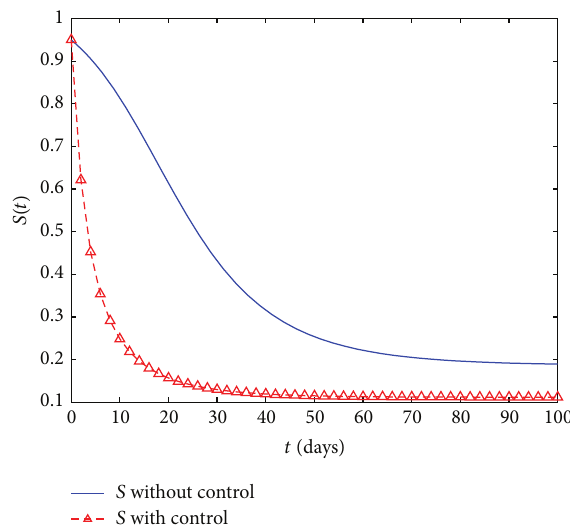
Figure 10: Susceptible individuals 𝑆(𝑡) in case of optimal control versus without control.